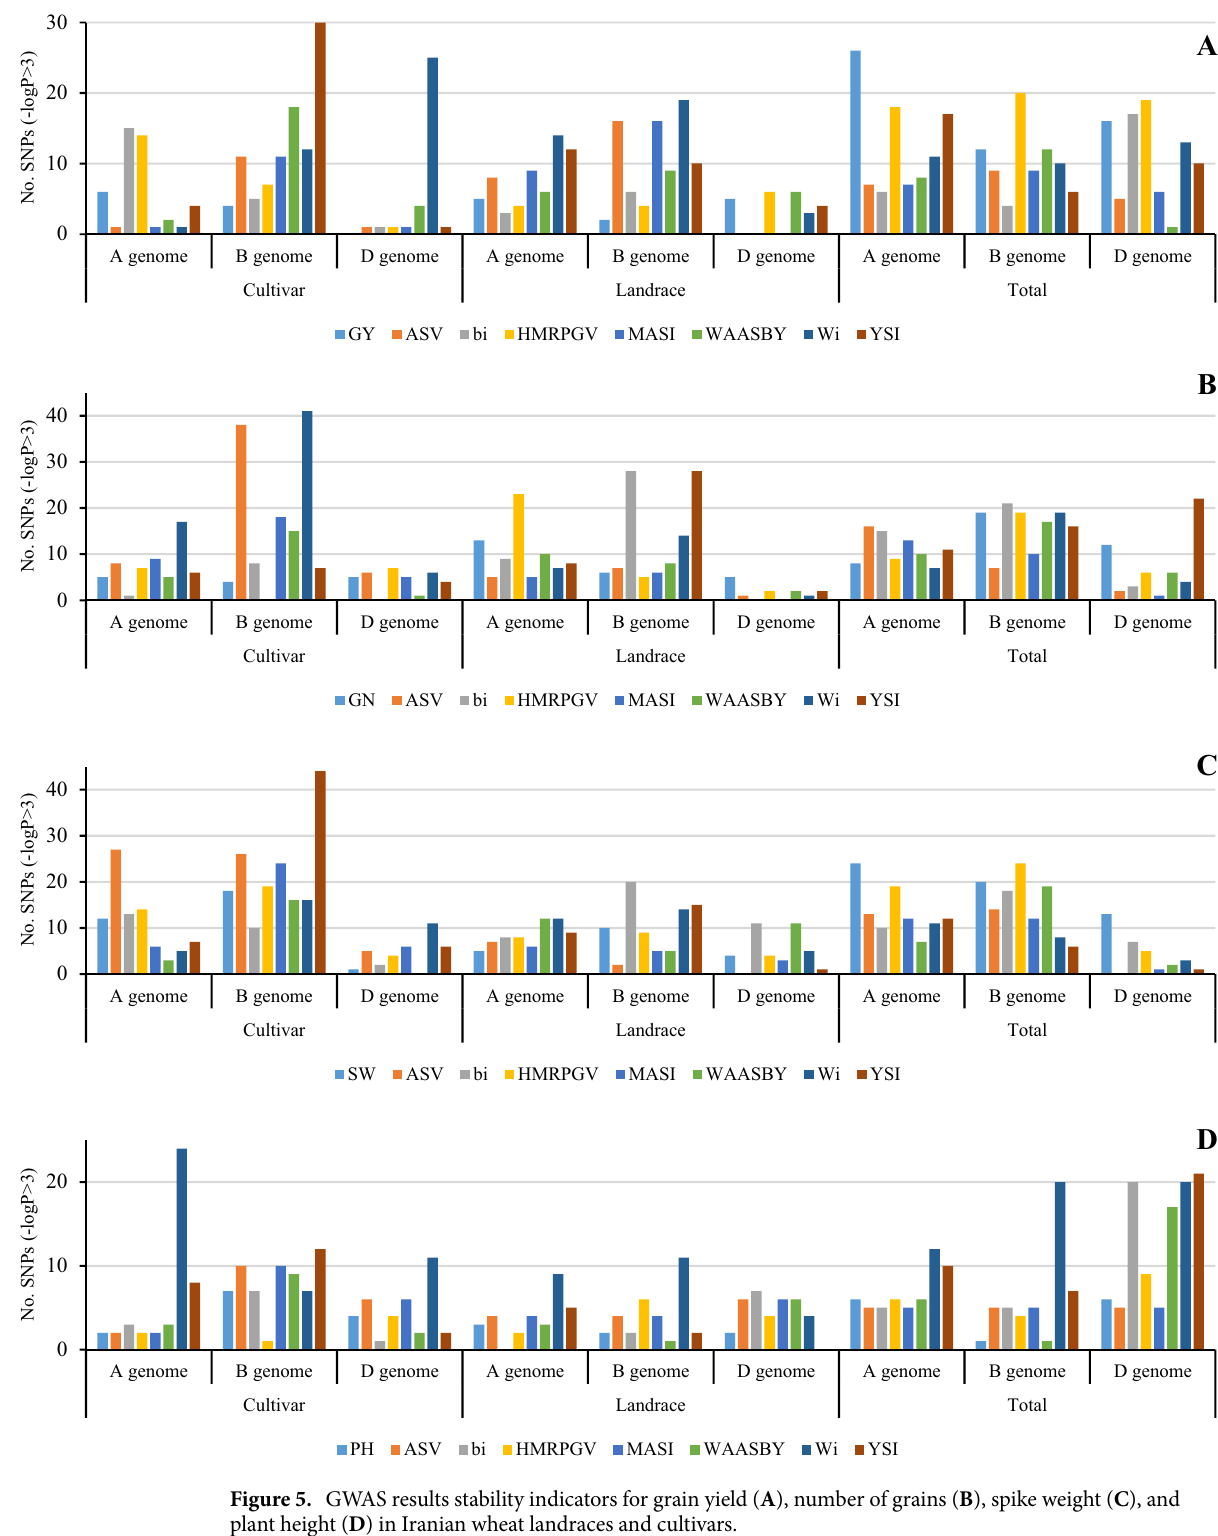
Figure 5. GWAS results stability indicators for grain yield ( A ), number of grains ( B ), spike weight ( C ), and plant height ( D ) in Iranian wheat landraces and